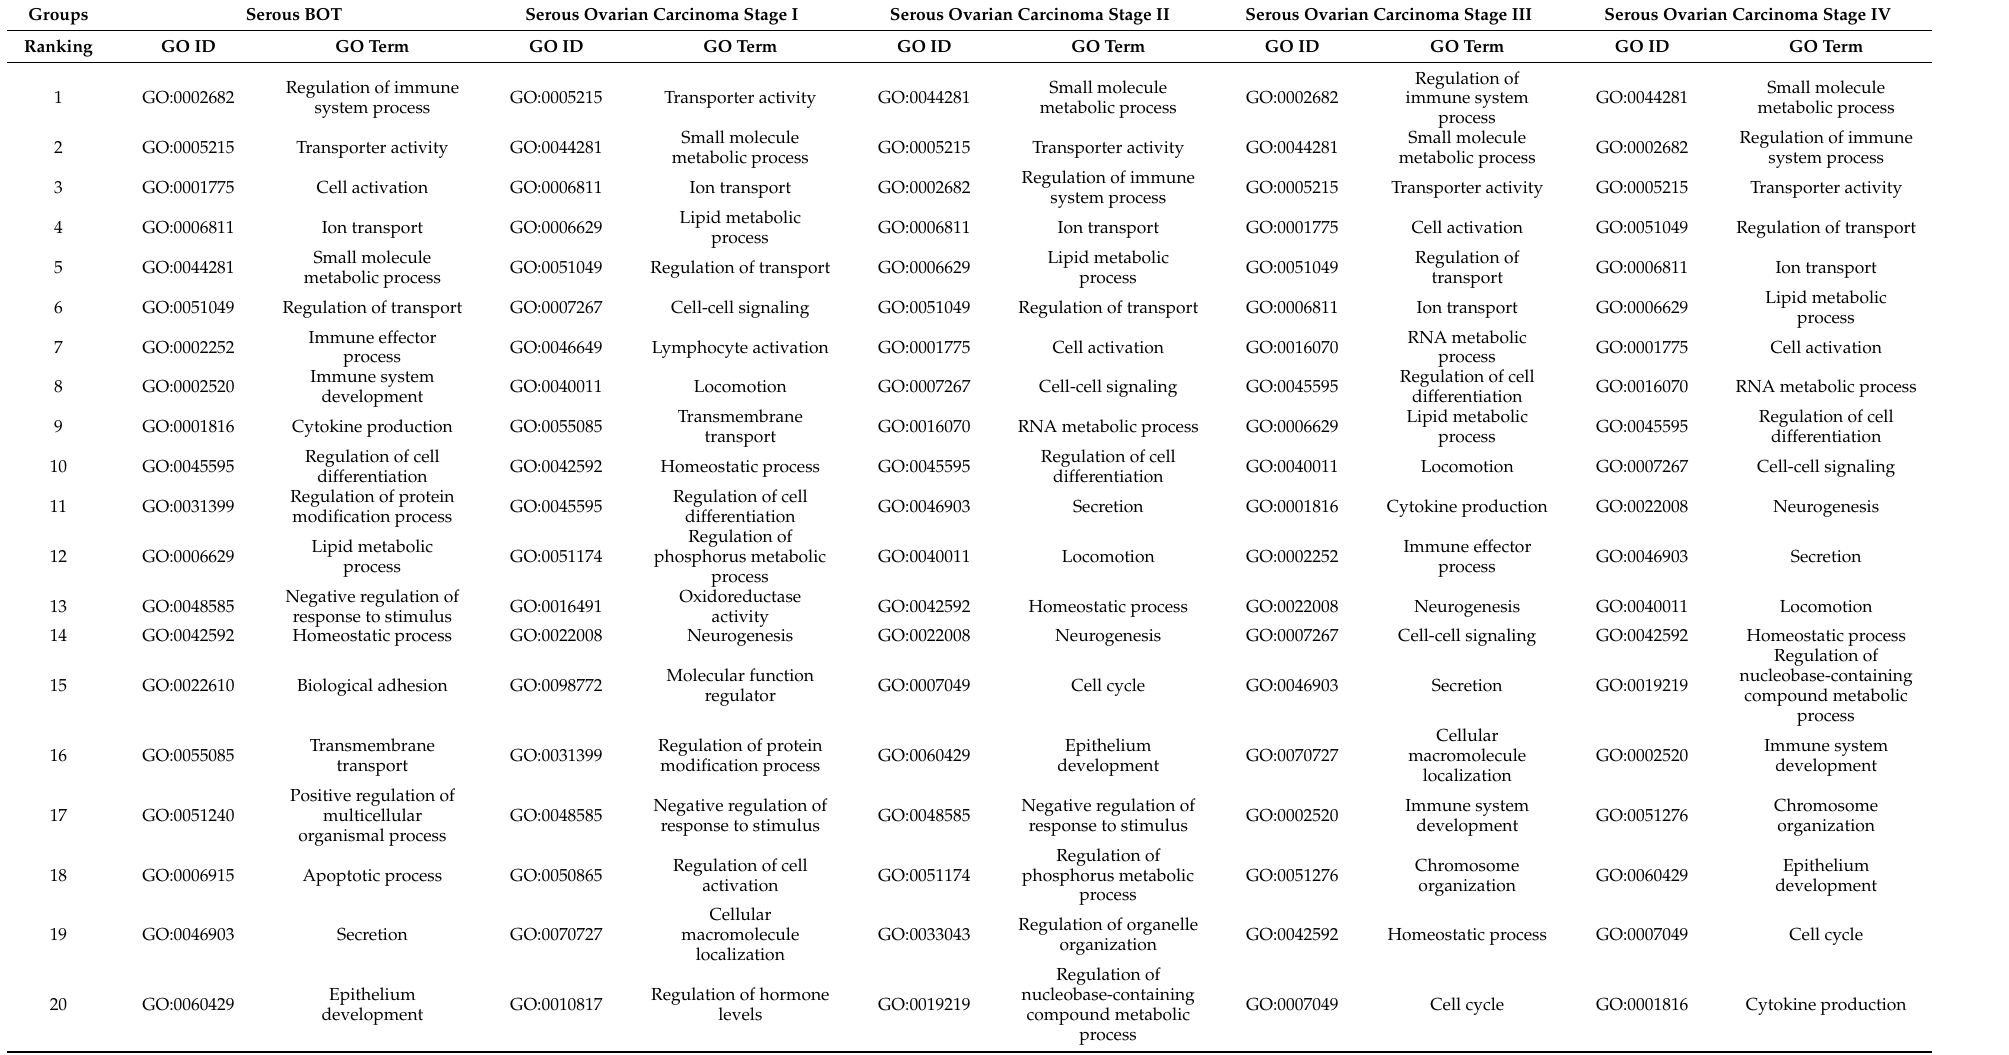
Table 2. The 50 most dysregulated GO terms for serous BOT and all stages of serous ovarian carcinoma ranked by cluster weight index